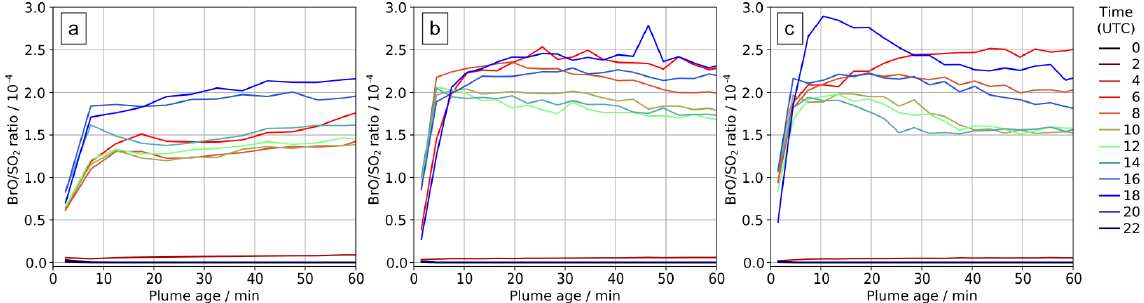
Figure 10. In-plume average BrO / SO 2 ratios for parts of the plume at different ages ranging from 0–60min at several times on (a) 30 July 2012, (b) 31 July 2012, and (c) 1 August